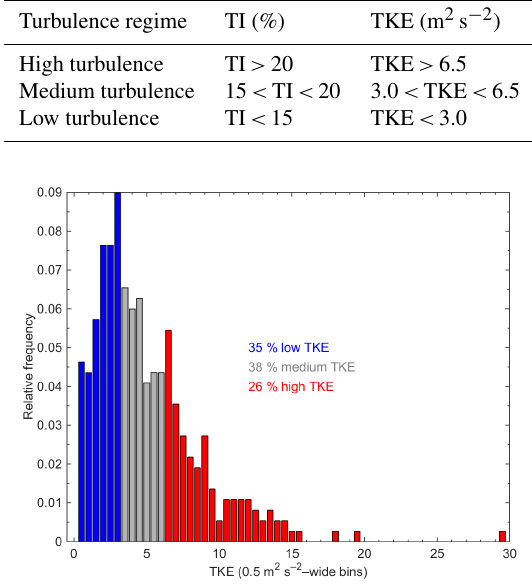
Figure 15. TKE distribution using thresholds in Table 3. In- cludes data filtered for tower 80m wind speeds between 3.5 and 25.0ms − 1 , 87m wind directions between 235 and 315 ◦ , and for normal turbine